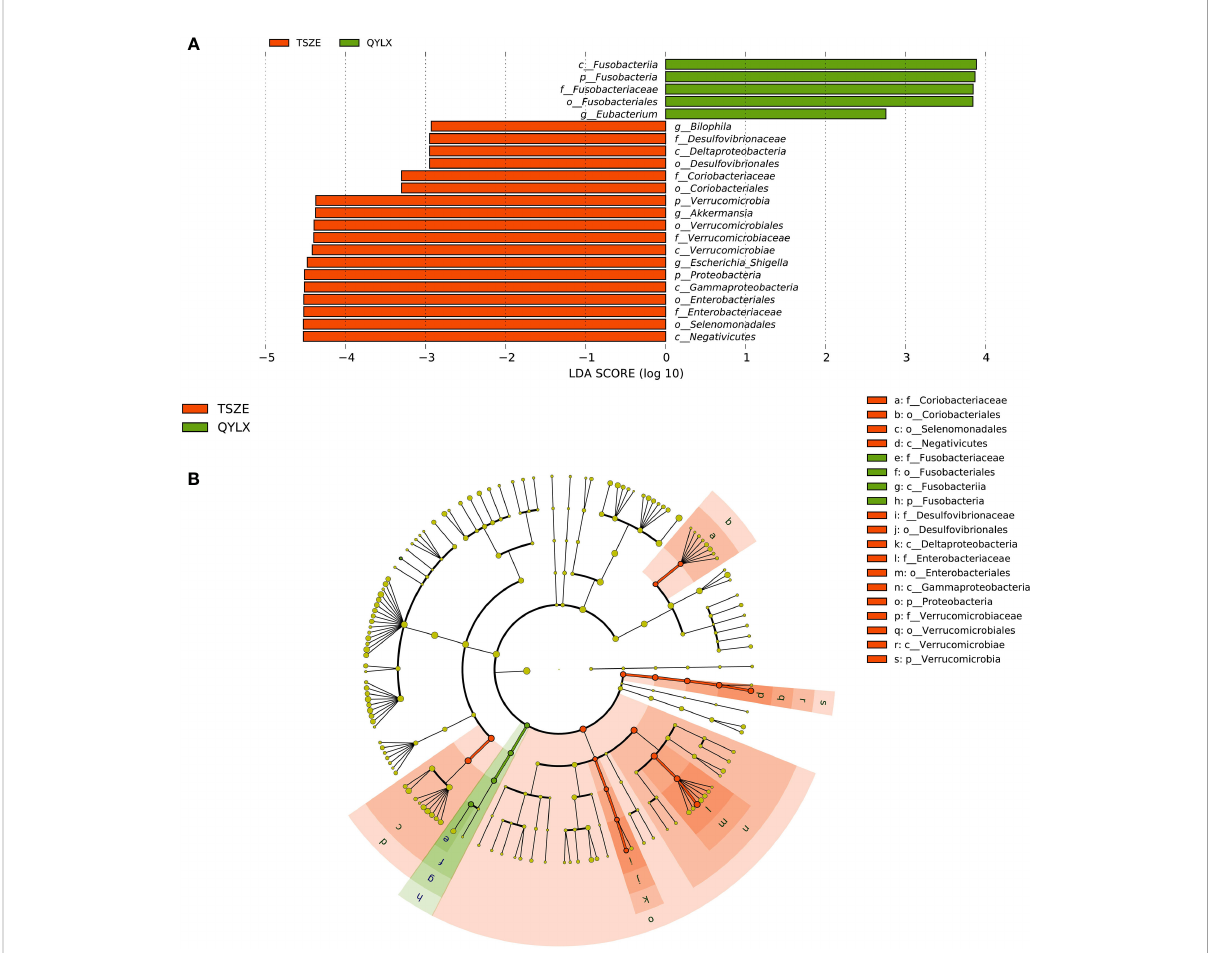
FIGURE 3 Speci fi c microbiota taxa at various taxonomic ranks differentially enriched in QYLX and TSZE patients. (A) The full list of signi fi cant microbial taxa is identi fi ed with LefSe (linear discriminant analysis effect size), at p value < 0.05 and log10-transformed LDA score > 2. (B) A cladogram showing the enriched microbial taxa on a phylogenetic tree. The color indicates which branch of the phylogenetic tree more signi fi cantly represents a certain group. Green: microbial taxa enriched in QYLX group; orange: microbial taxa enriched in TSZE group. QYLX, qi-yin de fi ciency syndrome; TSZE, phlegm-dampness